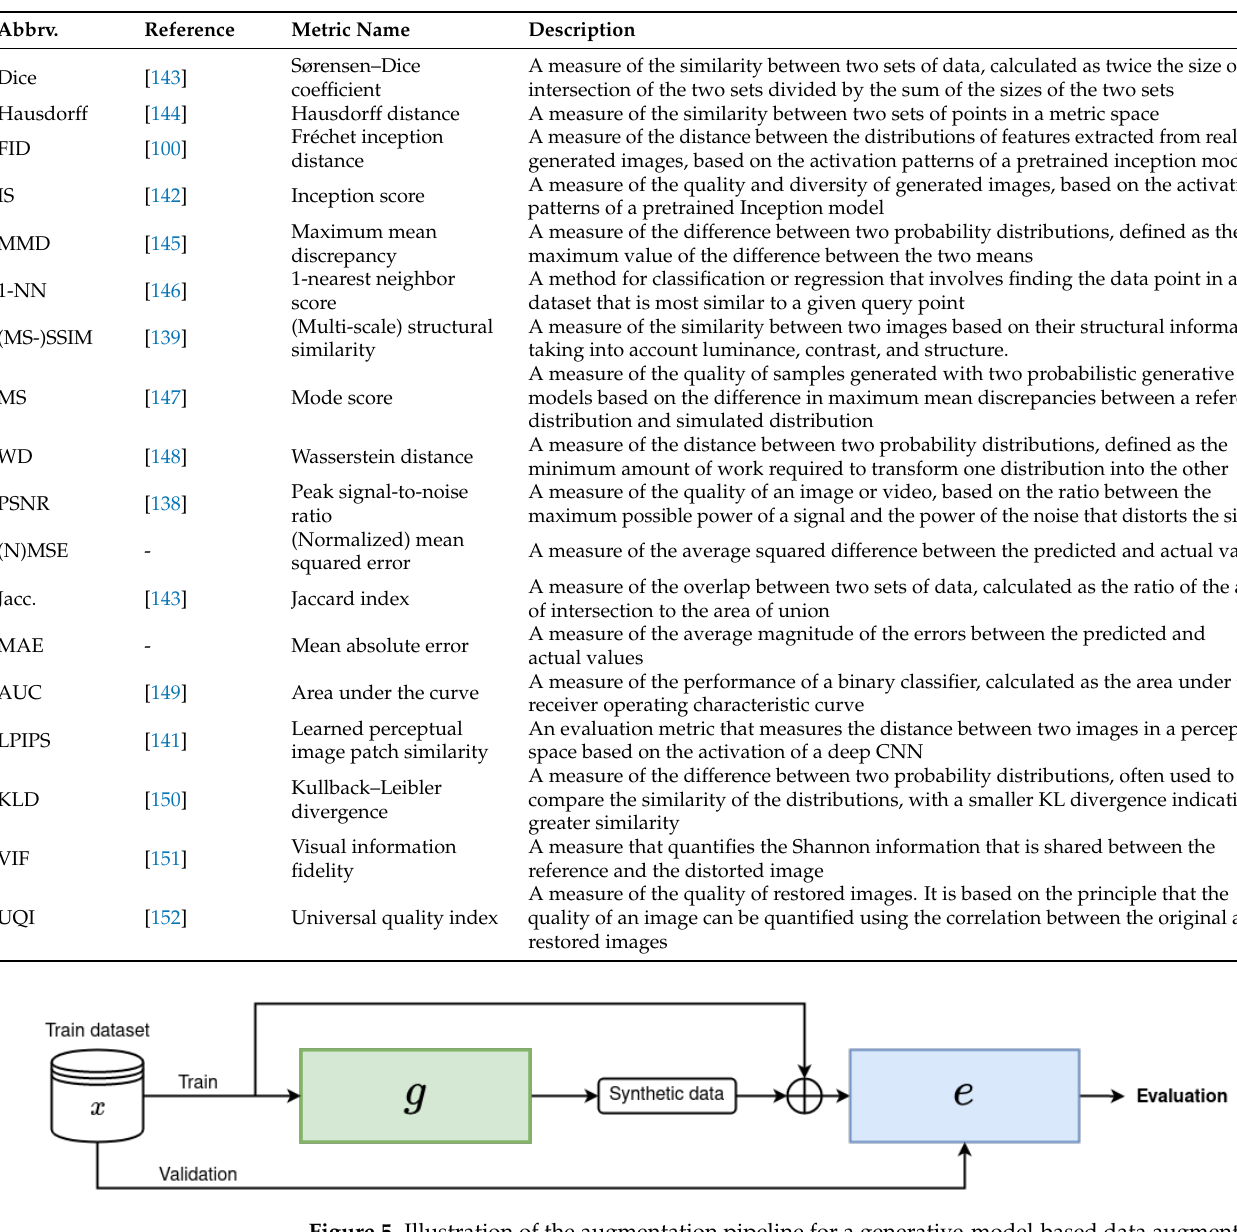
Table 5. Summary of quantitative measures used in the reviewed publications.